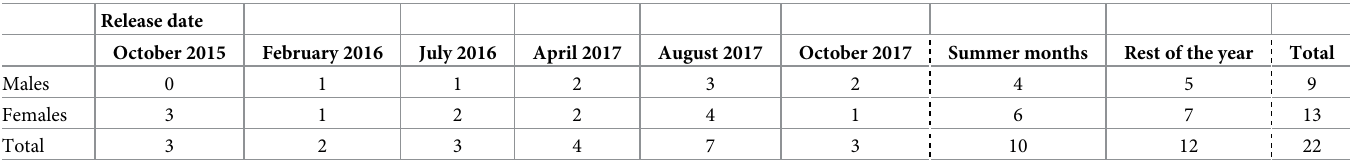
Table 1. Release date and sex data for all brown hare involved in the